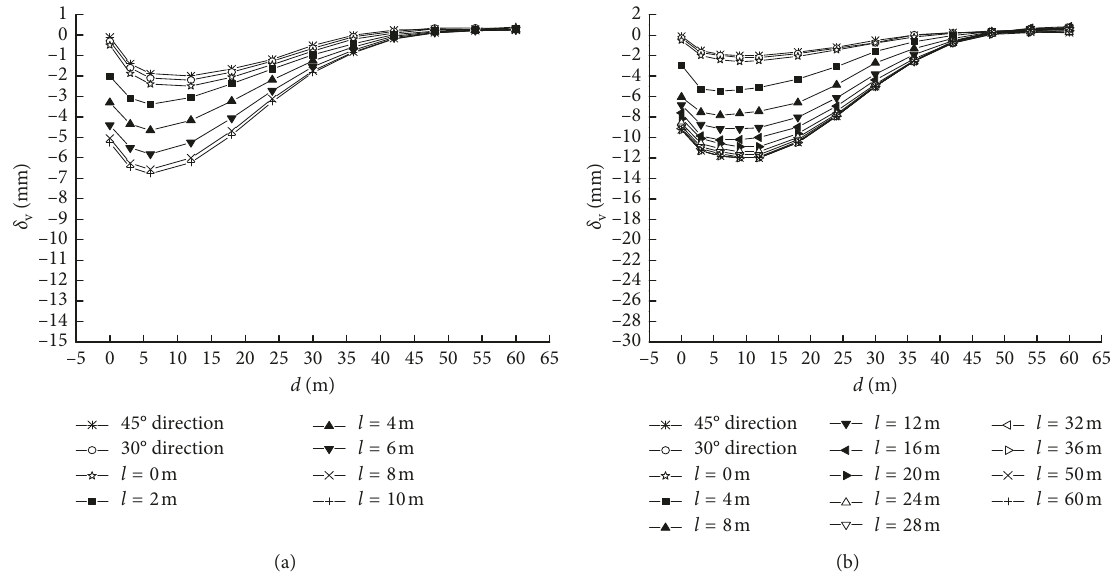
Figure 4: Ground surface settlements at different positions: (a) short side and (b) long side.